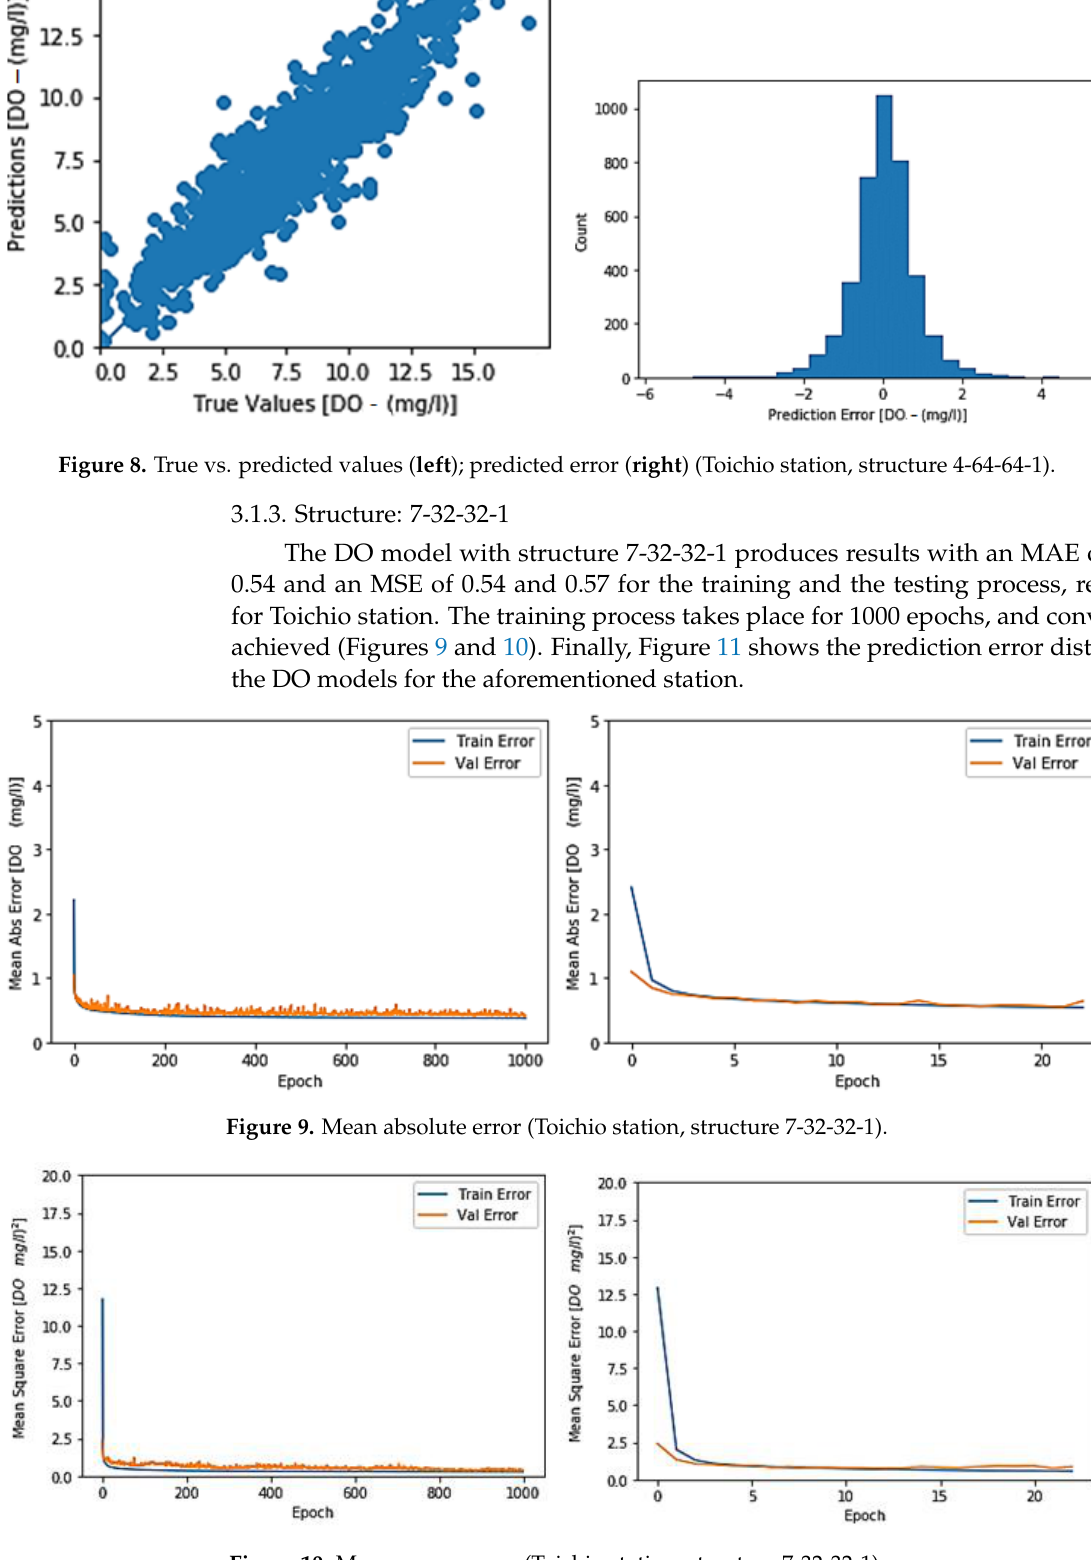
Figure 10. Mean square error (Toichio station, structure 7-32-32-1)